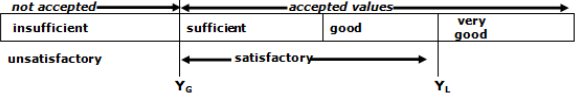
Figure 2: Illustration of the selection of the range of values satisfac- tory for criterion Y [16–18]